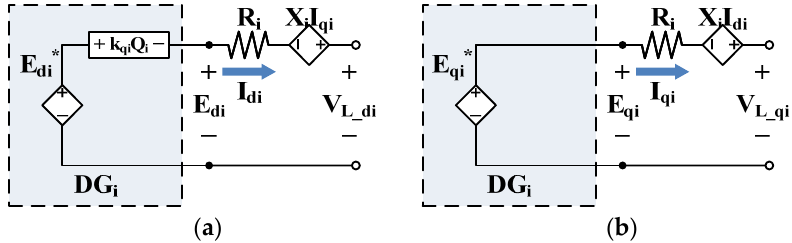
Figure 4. d ‐ q equivalent circuits for DG connected to load considering line impedance: ( a ) d ‐ axis; ( b ) q ‐ axis.